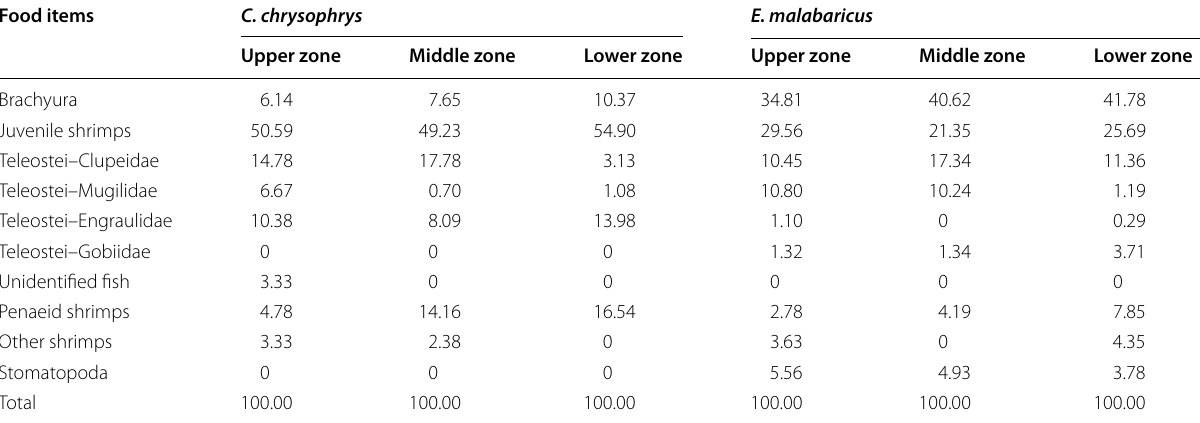
Table 2 Prey-specific index of relative importance (%PSIRI) for the predatory fish in the Pangani estuarine zones Food items C.